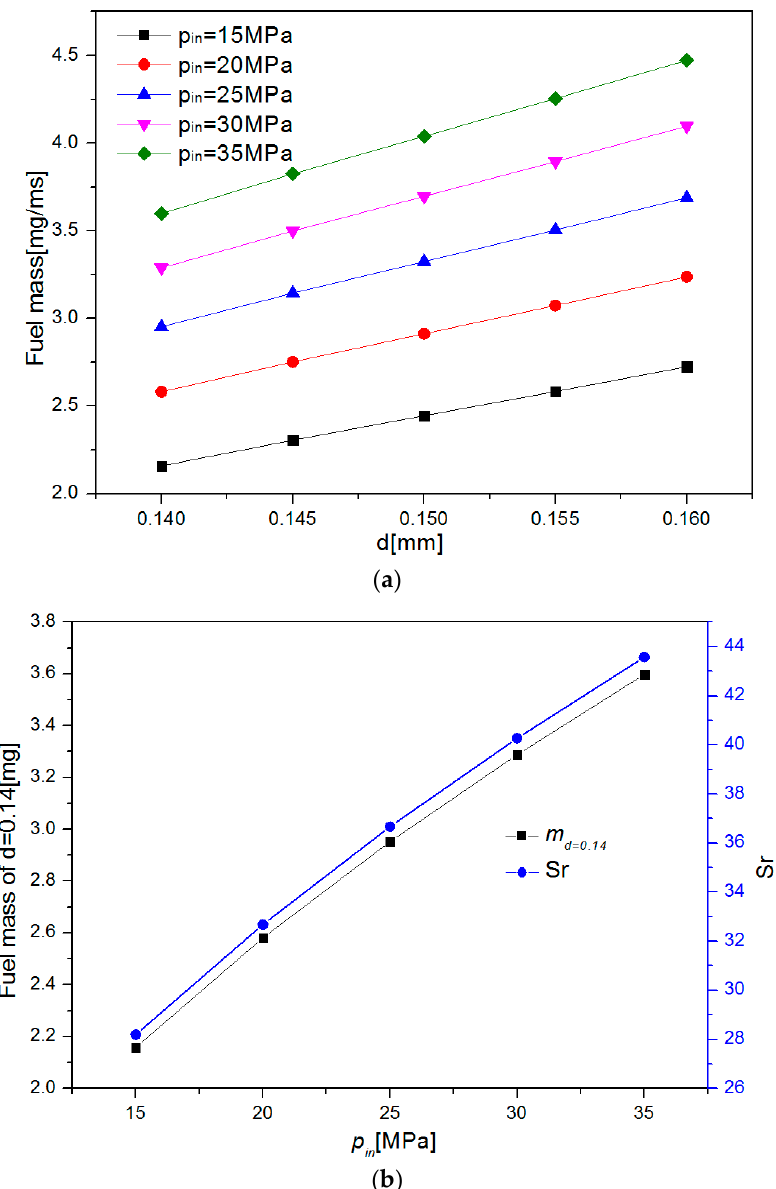
Figure 10. Sensitivity analysis of cyclic fuel mass to nozzle diameter under different injection pressure. ( a ) The effect of injection pressure and nozzle diameter on the fuel mass, ( b ) Sensitivity of single-nozzle cycle fuel mass to injection pressure.